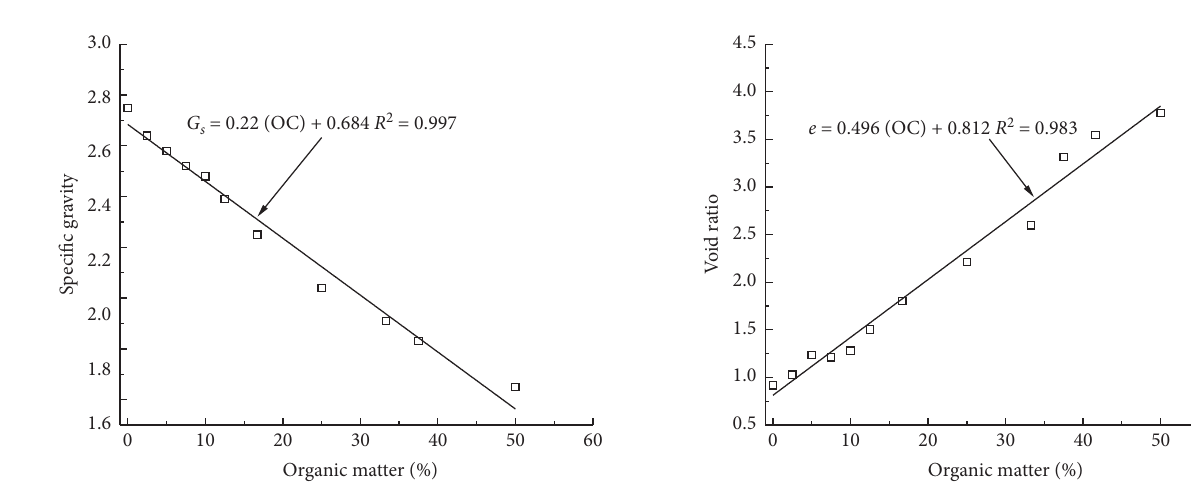
Figure 5: Change of void ratio against organic content.